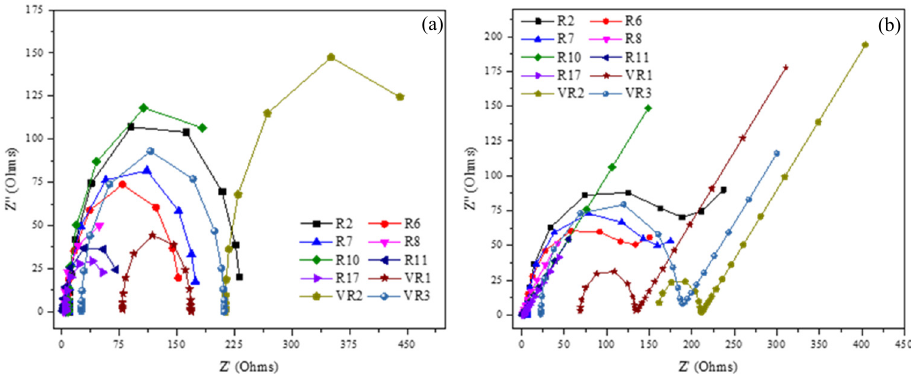
Figure 4. The impedance studies for selected experimental runs along with validation runs a) Randles and b) Randles + Warburg circuits.